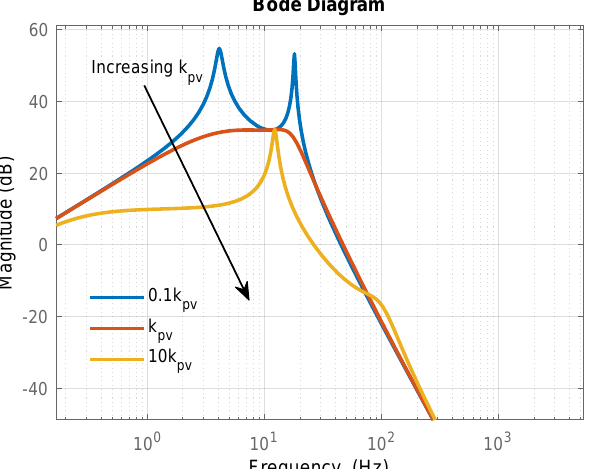
Figure 21. Sensitivity of DC input Impedance Z ic to k pv in increasing order of 0.1 × , 0.1 × , 1 × , and 10 × k pv (base case).